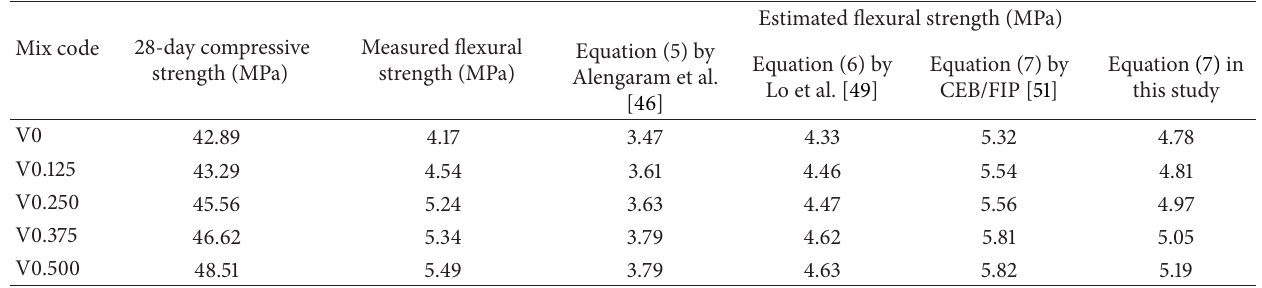
Table 6: Measured and estimated flexural